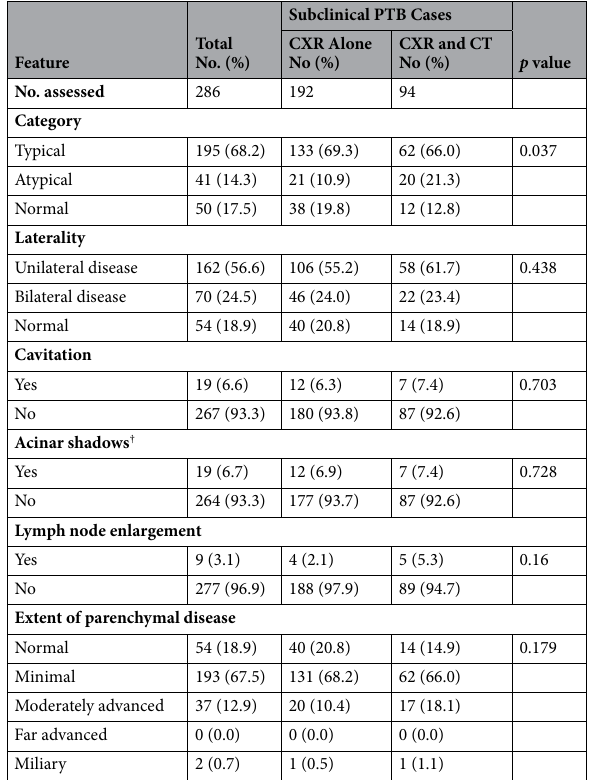
Table 3. Chest radiographic features of subclinical pulmonary tuberculosis in patients with and without a computed tomographic scan Abbreviations: PTB pulmonary tuberculosis; CXR chest x-ray; CT computedtomography. The proportions of all patients (“total” column) with the features have been previously reported (see reference #6). † Information on acinar shadows on the chest radiograph was unavailable in three